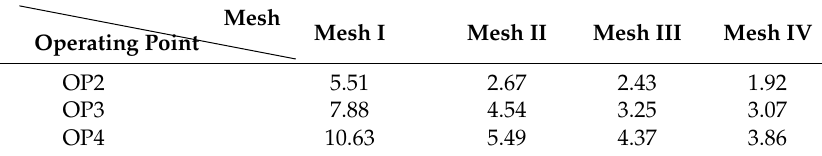
Table 4. Mesh independence checks.